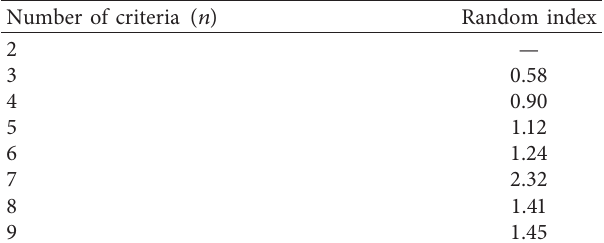
Table 3: Scale of variation of the random index